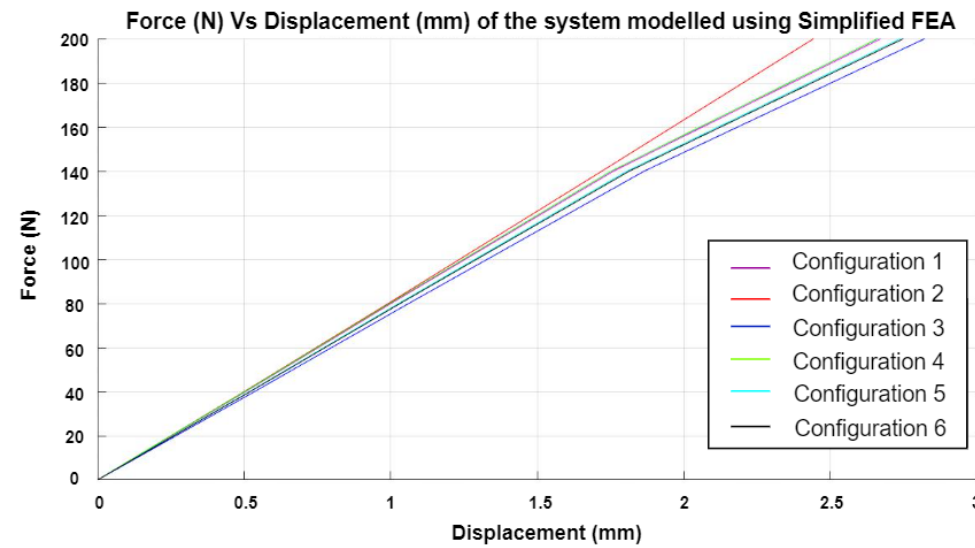
Figure 19. Force displacement graph based on FEA results of simplified model. Configuration 1—Magenta, Configuration 2—Red, Configuration 3—Blue, Configuration 4—Green, Configuration 5—Cyan, Configuration 6—Black.